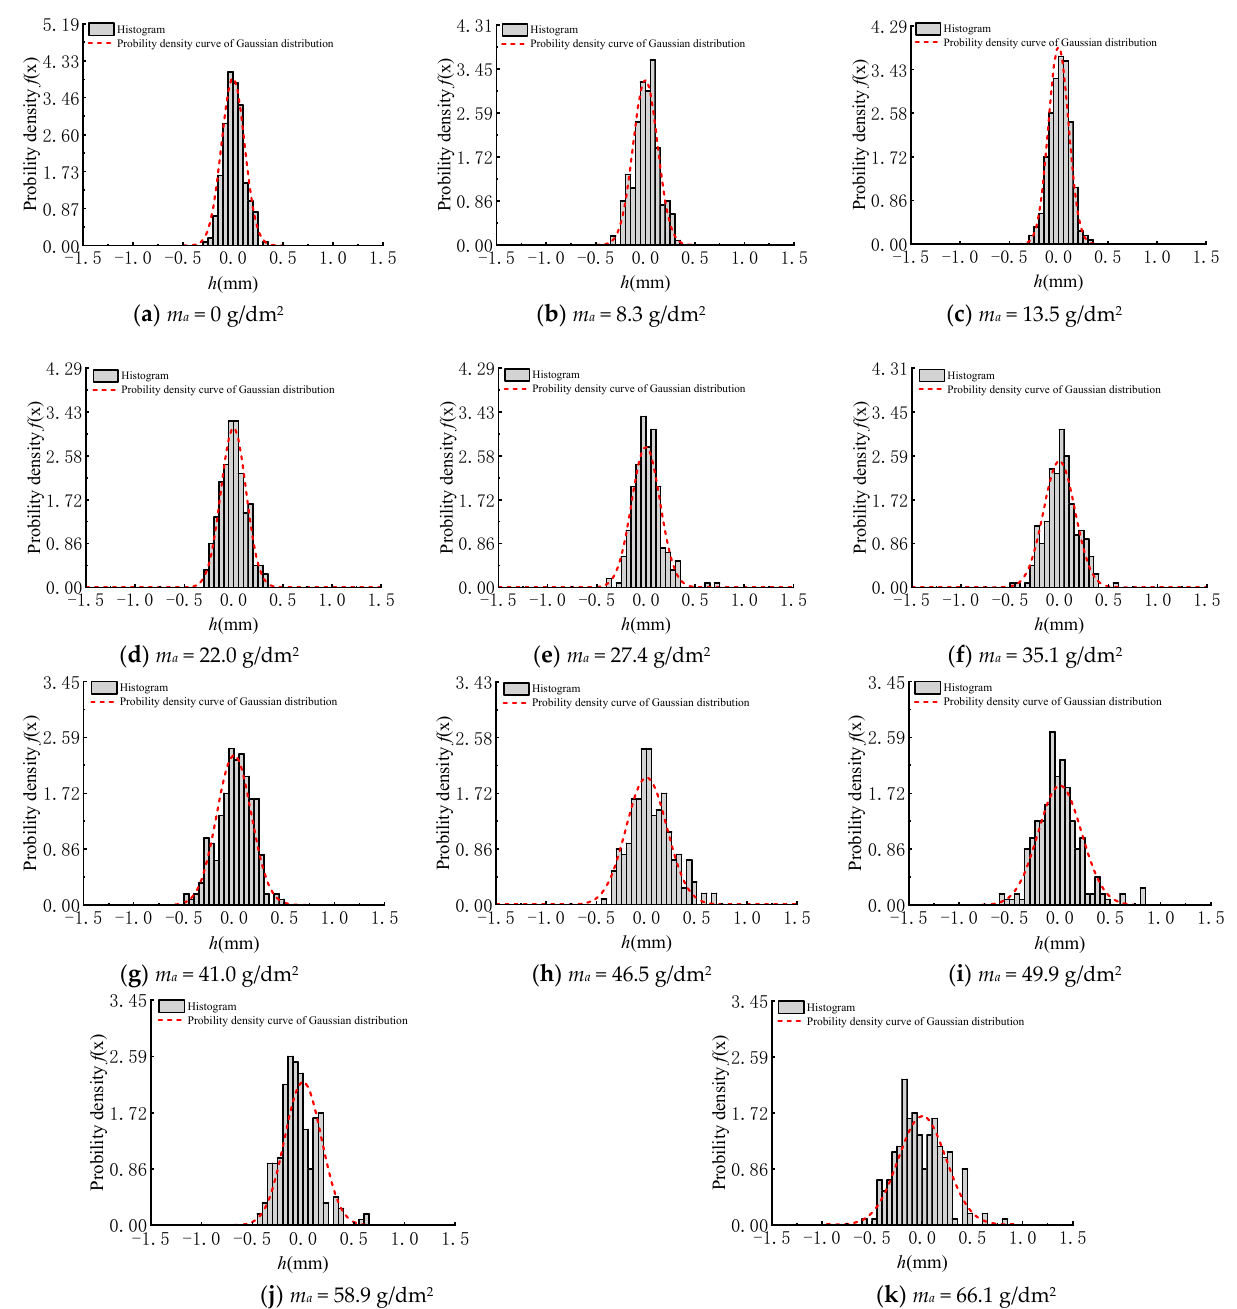
Figure 6. Probability density of surface height of two-dimensional contour curve.